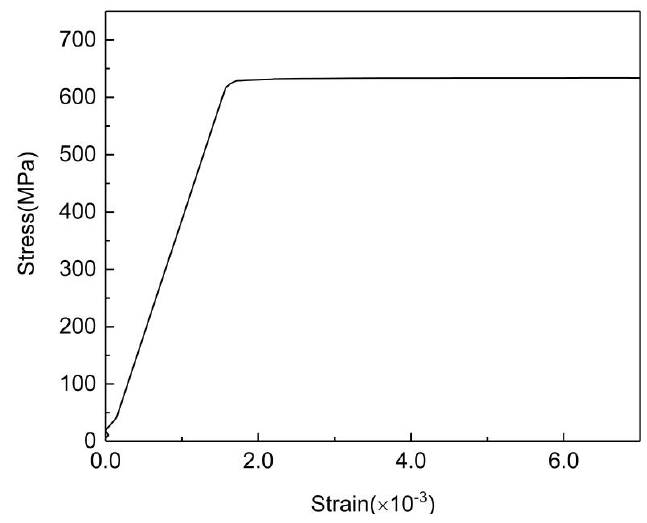
Figure 1. Tensile stress–strain curve of the X80 steel.